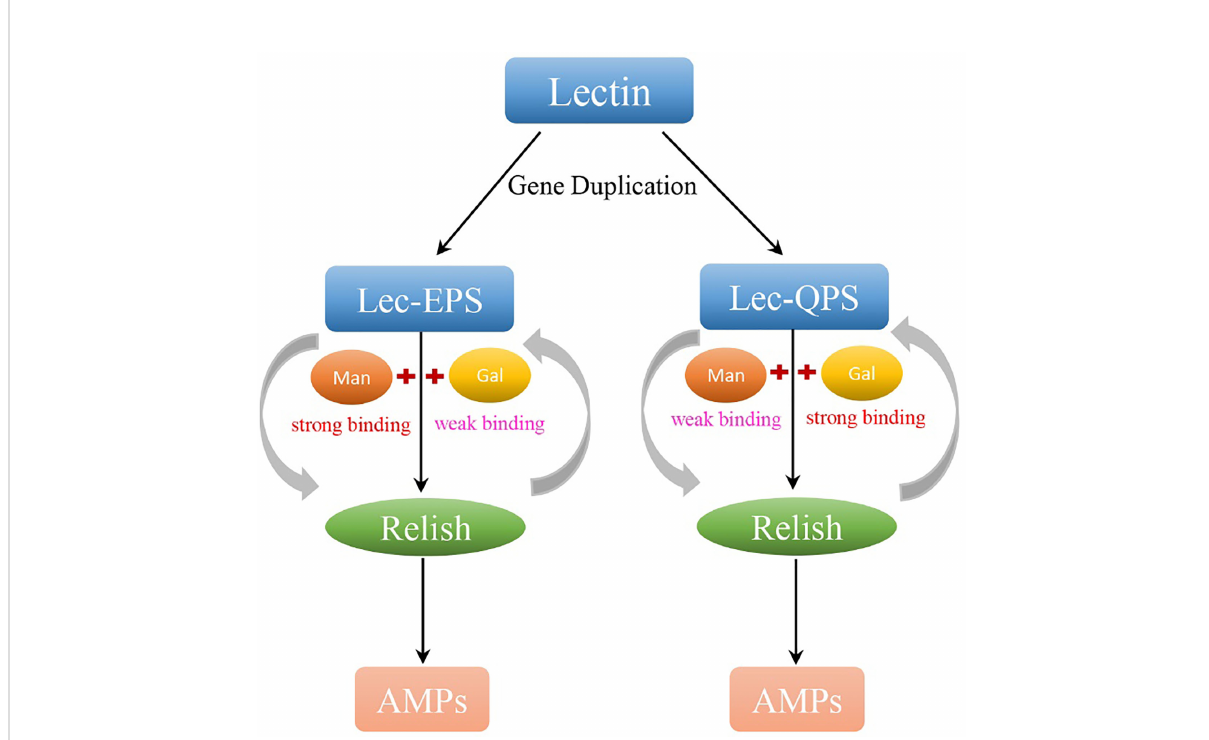
FIGURE 10 The carbohydrate recognition, immune responses, and expression regulation of PcLec-EPS and PcLec-QPS produced by GD. By GD, lectin in P. clarkii generates two CTLs with EPS and QPS motif, respectively. Lec-EPS and Lec-QPS in P. clarkii respectively strong recognize and bind D- Mannose (Man) and D-Galactose (Gal), activates the transcription of intracellular Relish, and further induces the expression of different AMPs. Moreover, the activated Relish positively regulates the transcription of Lec-EPS and Lec-QPS . There is a positive feedback loop between CTLs and Relish that may contribute to the expansion of the immune response for host quickly and ef fi ciently defensing against invading